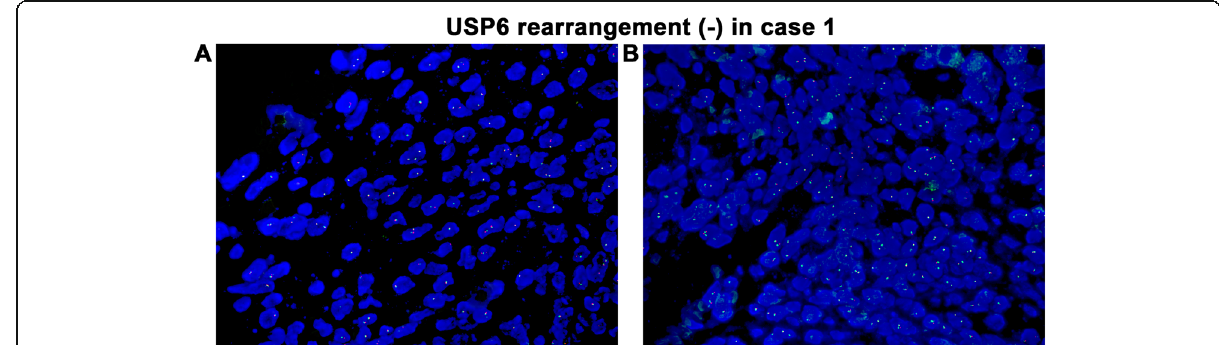
Fig. 4 USP6 rearrangement detection by a break-apart probe was negative in case 1. a , b Two different fields showing how the red and green signals did not break apart but rather appear in the same position or in close positions within the nuclei of the spindle-cell population, which should be interpreted as negative according to the manufacturer ’ s criteria (×